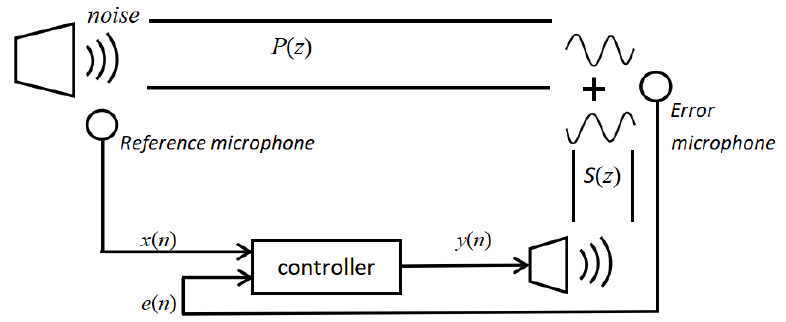
Figure 1. Schematic diagram of the feed-forward active noise control system.